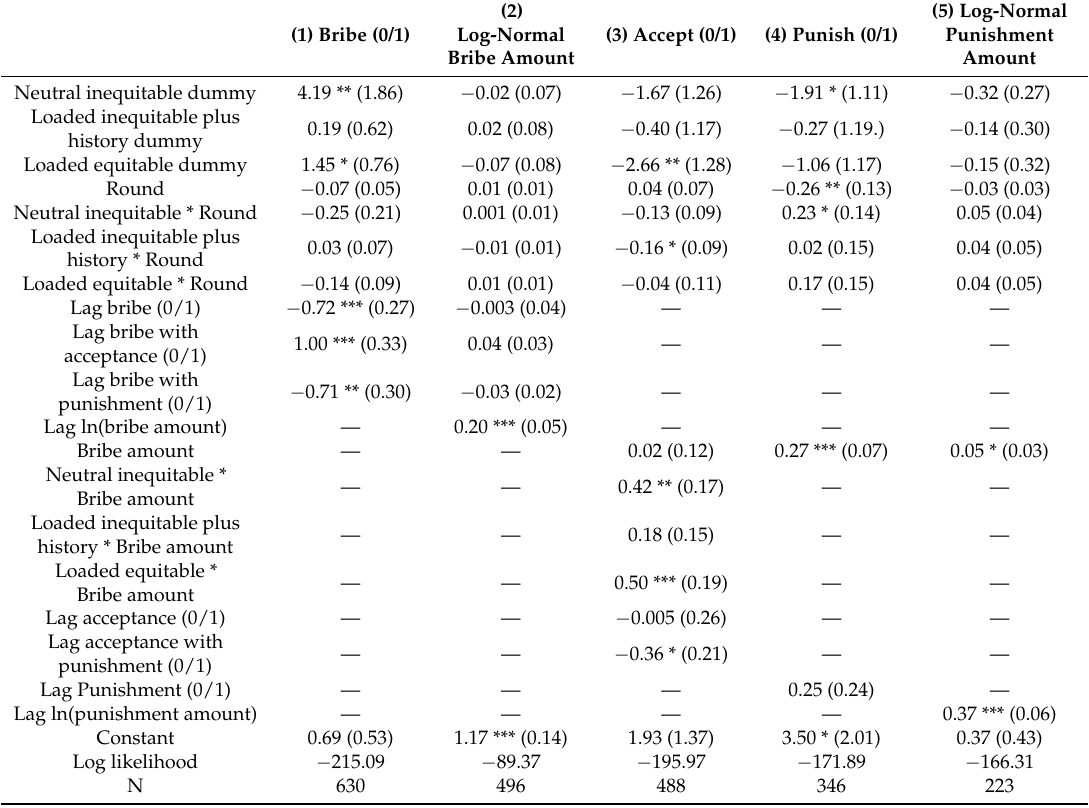
Table 4. Regression results – effects of framing, history and inequity